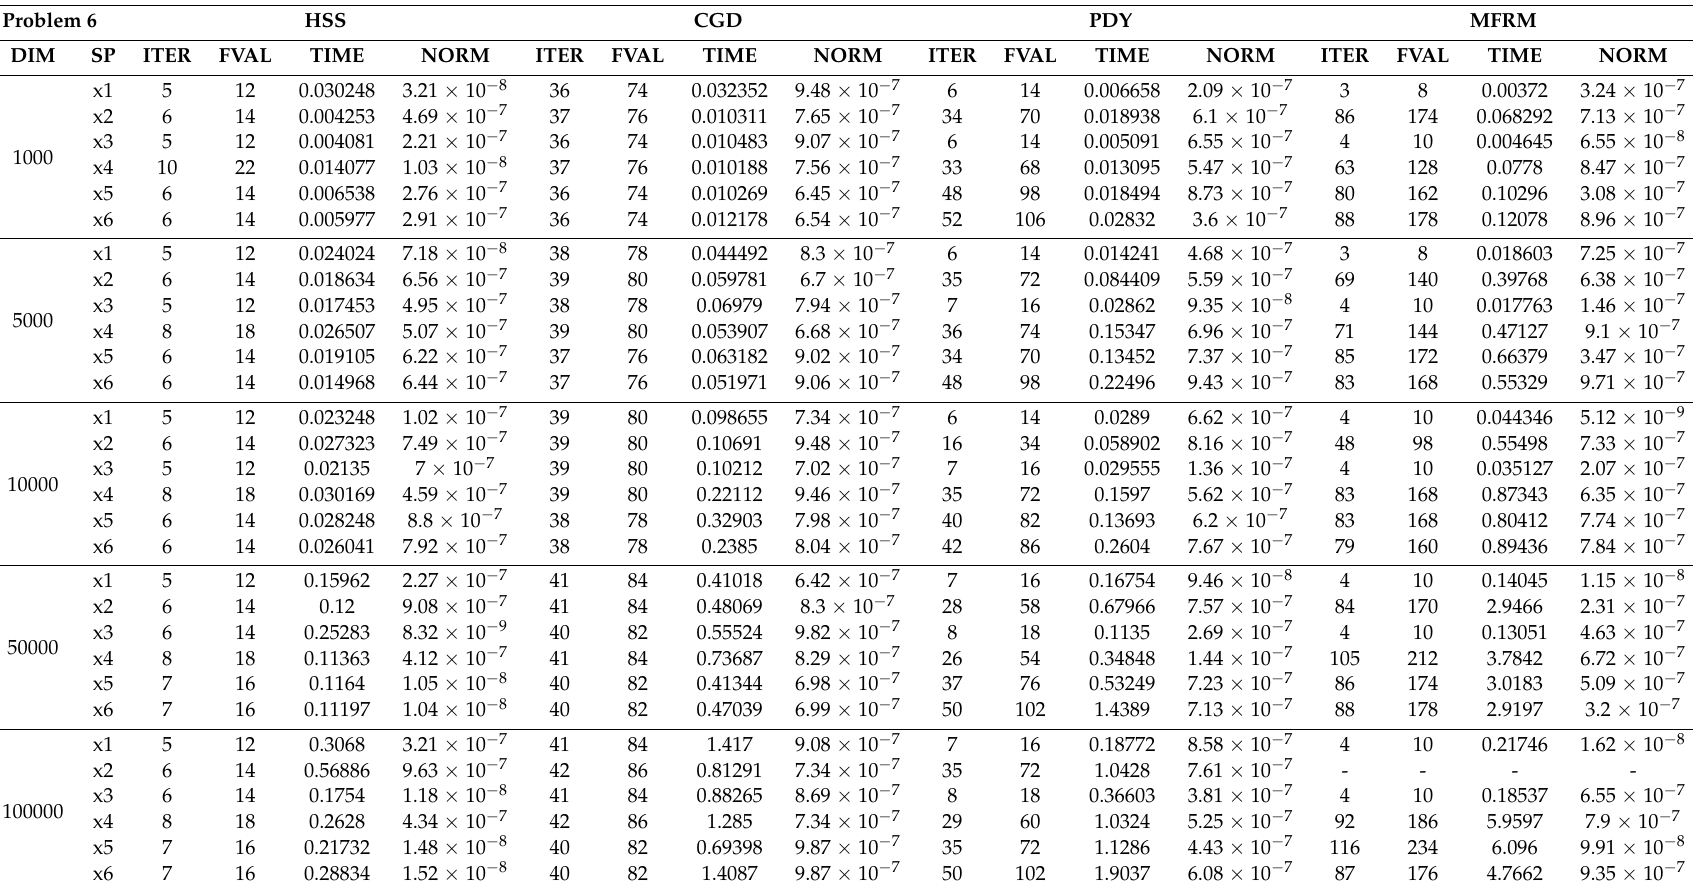
Table 6. Test results obtained by the four solvers for Problem